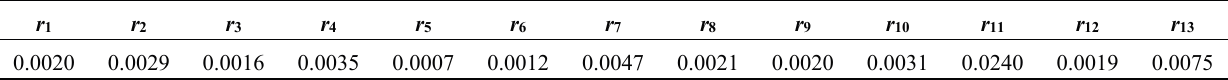
Table 1. The average correlation coefficients of the training samples.